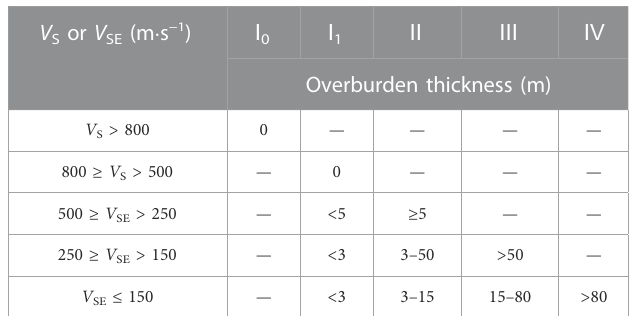
TABLE 1 Site condition classi fi cation criteria in China.